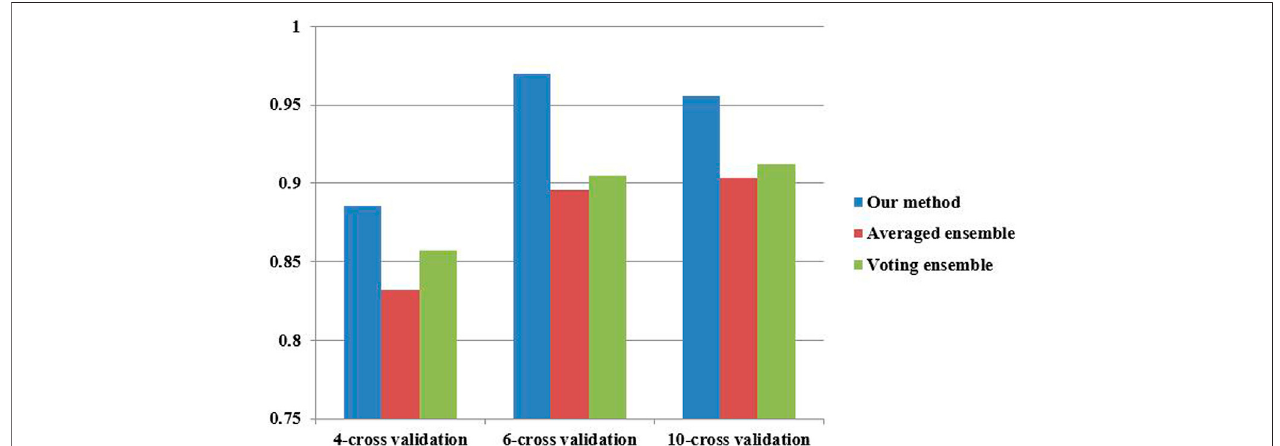
FIGURE 10 | F1 performances of hypertension-related compound by three ensemble methods.